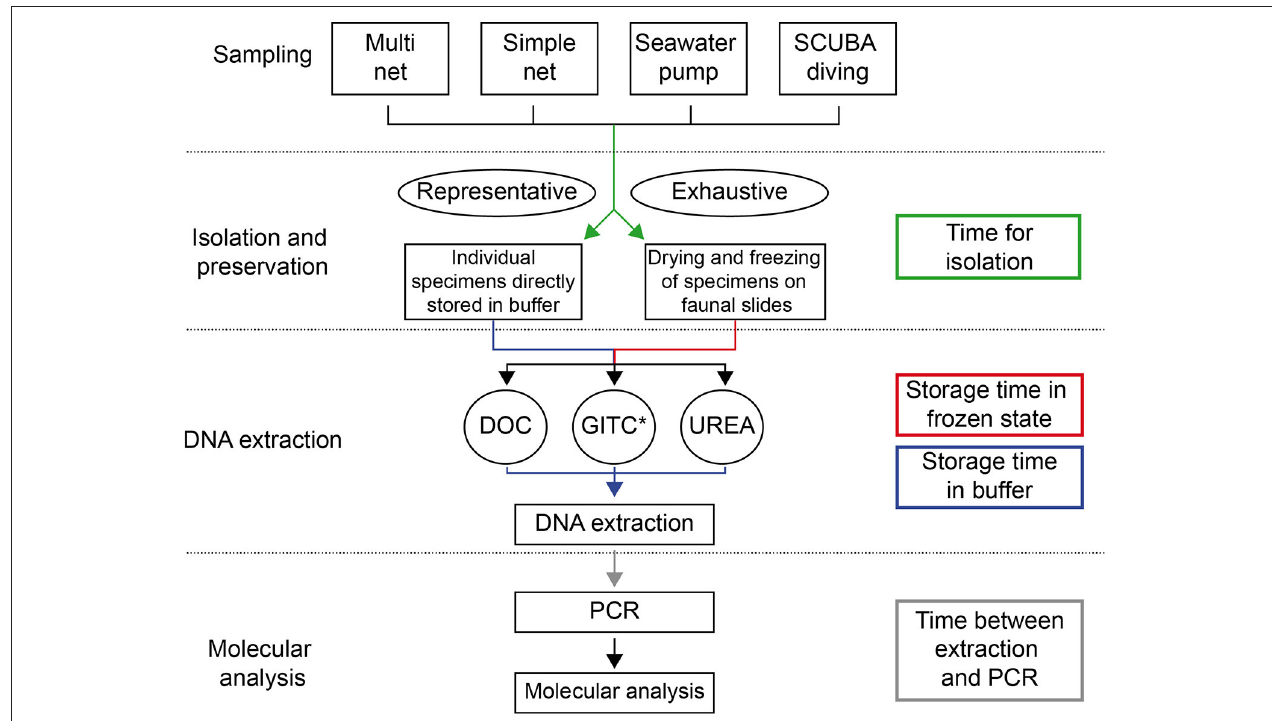
FIGURE 1 | Methodological pathway for the genetic analysis of planktonic foraminifera, representing the different existing methods and their linkage. The processing/storage times between different steps, which potentially influence success rates of DNA amplification, are represented by colored arrows.